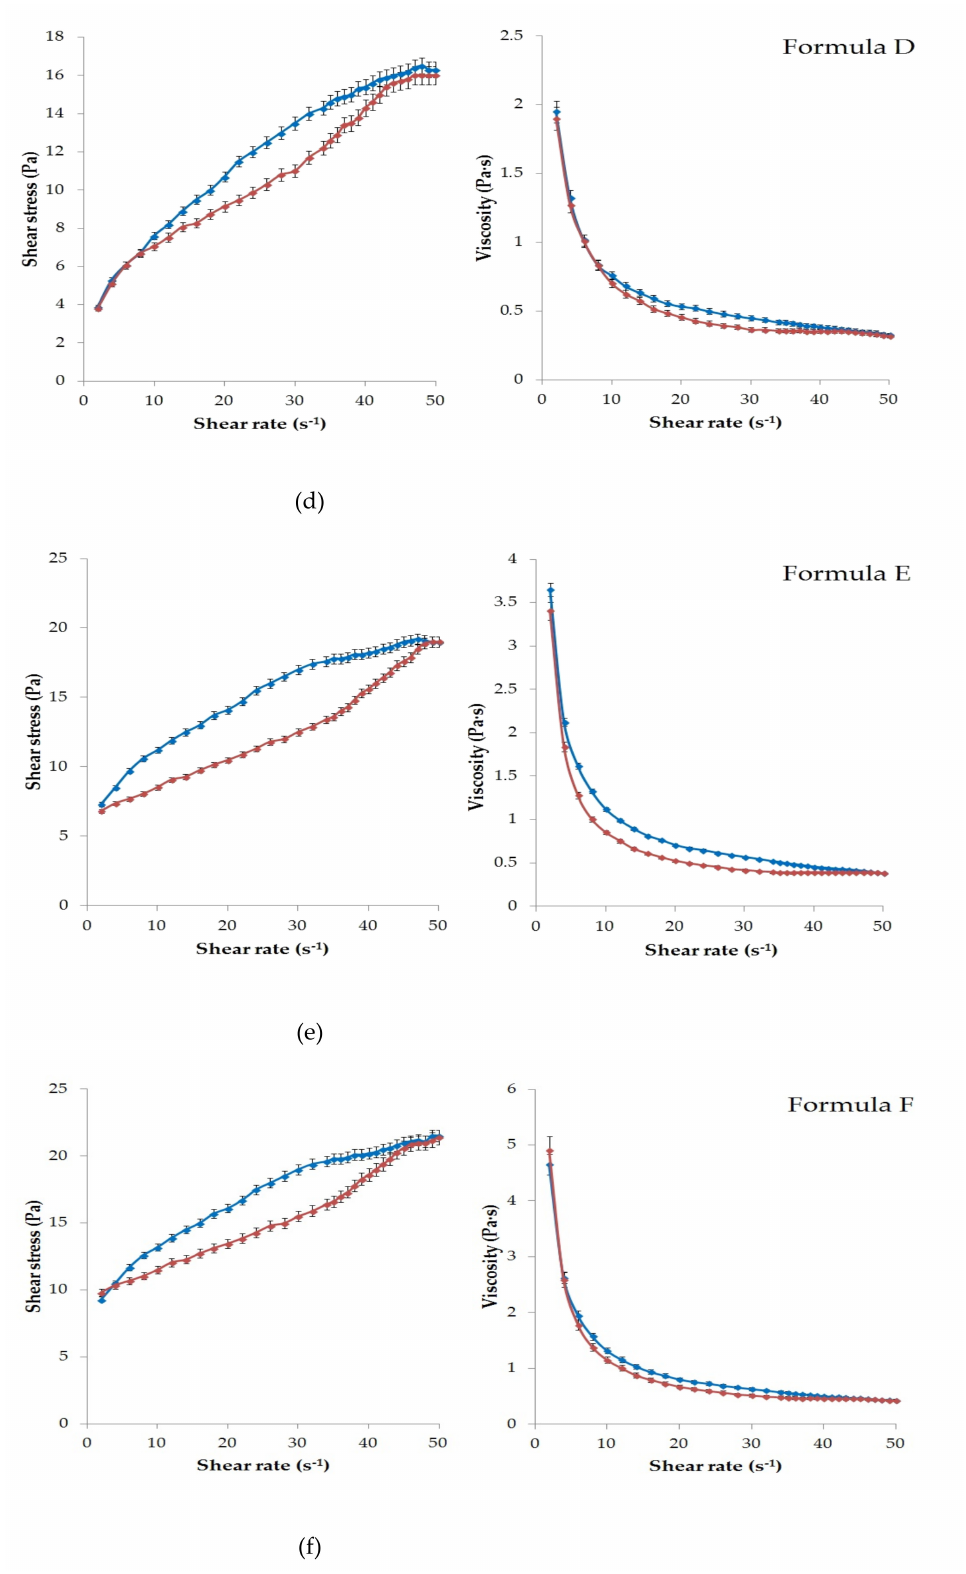
Figure 1. Flow curves of the ointment and gel samples plotted as shear stress (Pa) (left) and viscosity (Pa · s) (right) against shear rate. The rheological characteristics of ( a ) Formula A, ( b ) Formula B, ( c ) Formula C, ( d ) Formula D, ( e ) Formula E and ( f ) Formula F are presented. Each data point represents the mean ± S.D., n = 3. Shear rate was first increased from 0.01 to 50 s − 1 (up curve, signed with blue) and then decreased from 50 to 0.01 s − 1 (down curve, signed with red) to check possible hysteresis